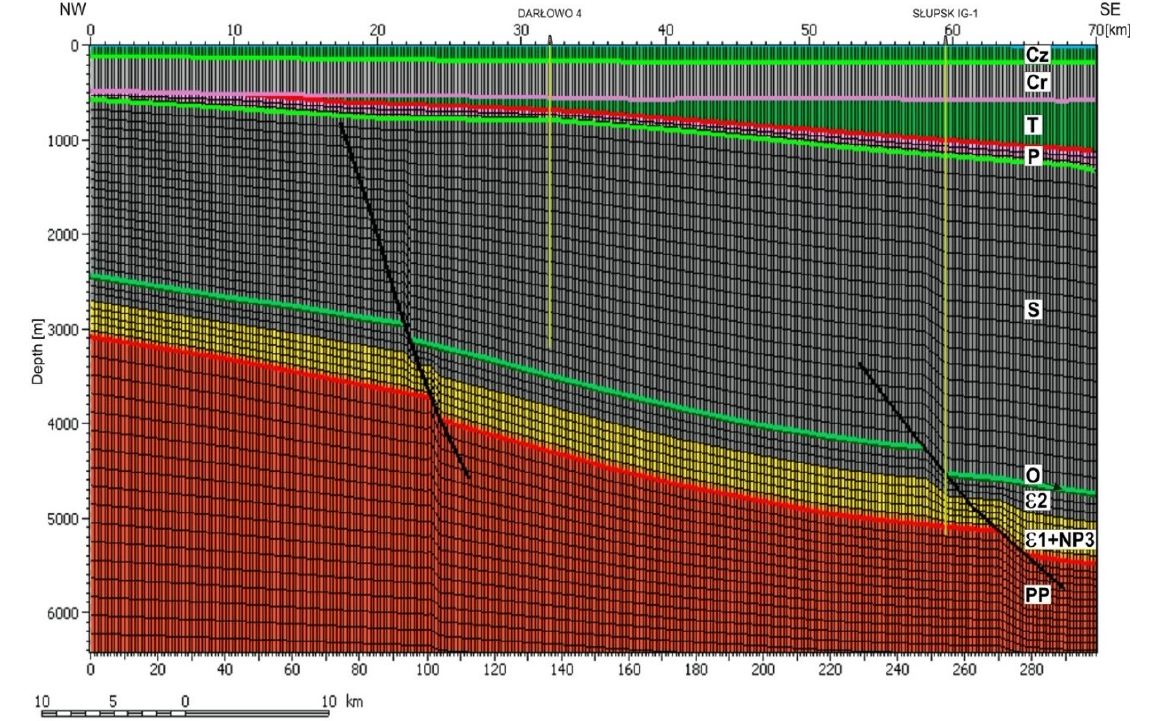
Figure 6. Finite element mesh for modeled mechanical and chemical compactions and paleothermal processes, referred to as A-A’ geological cross-section— Figure 3. Colors correspond to lithologic and facies development. Yellow—sandstone facies of Ediacaran–Lower Cambrian succession. Stratigraphic symbols as in Figure 3.